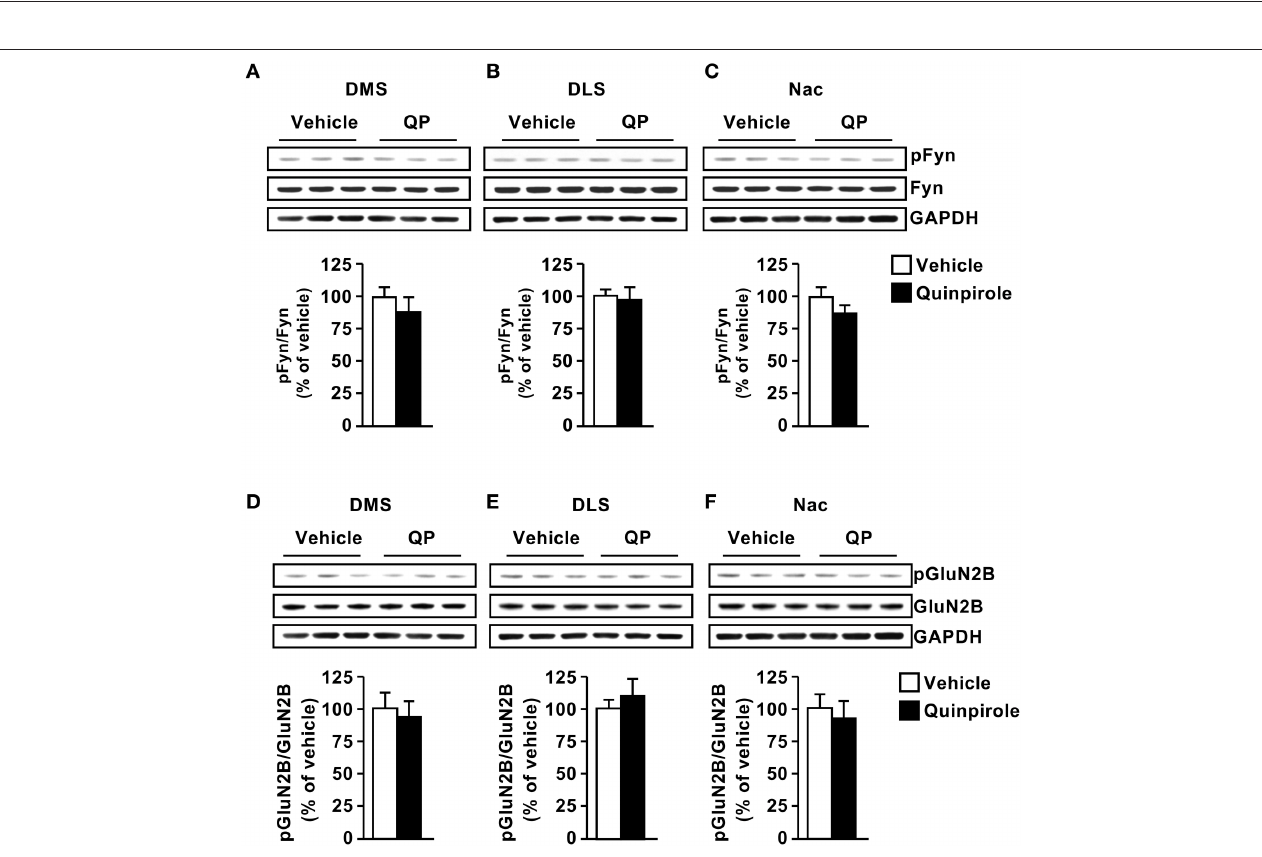
FIGURE 3 | Dopamine D2 receptor stimulation does not alter Fyn activation or GluN2B phosphorylation. Quinpirole (QP; 5 mg/kg) or saline was systemically administered (i.p.). The DMS (A,D) , DLS (B,E) , and NAc (C,F) were collected 15 min after drug administration. The level of Tyr420[Fyn] phosphorylation (pFyn) (upper panels), Fyn (middle panels) ( A–C ), Tyr1472[GluN2B] phosphorylation (pGluN2B, top panels), GluN2B (middle panels) ( D–F ) were measured by western blot analysis. The immunoreactivity of GAPDH (bottom panels) was used as a loading control (bottom panel). Data are presented as the mean densitometry value of the phosphorylated protein divided by the mean densitometry values of the total protein ± SEM and expressed as % of vehicle. Two-tailed t -test. n = 5–6 mice per treatment group.